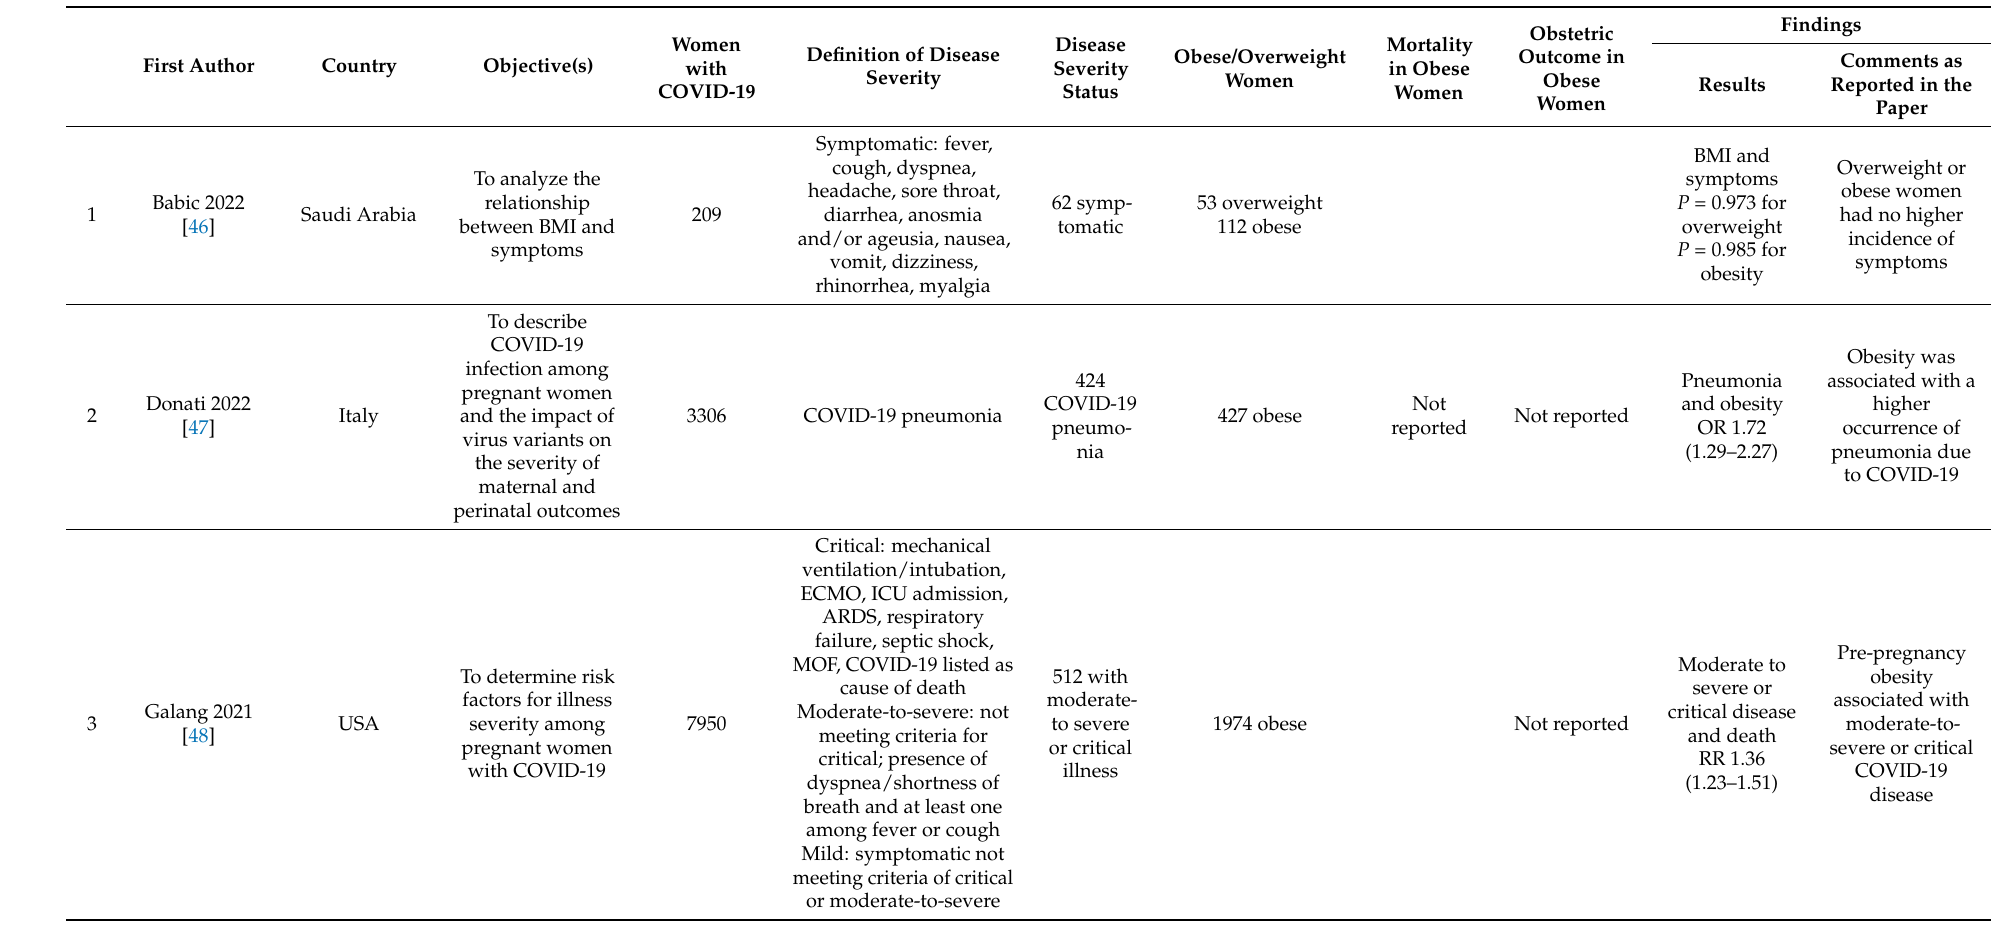
Table 1. Association of overweight/obesity with COVID-19 illness